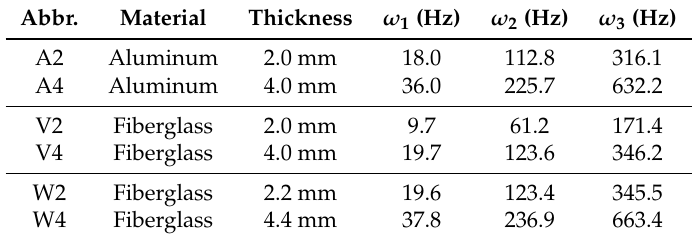
Table 2. First three theoretical dry natural frequencies of the panels composing the wedges.